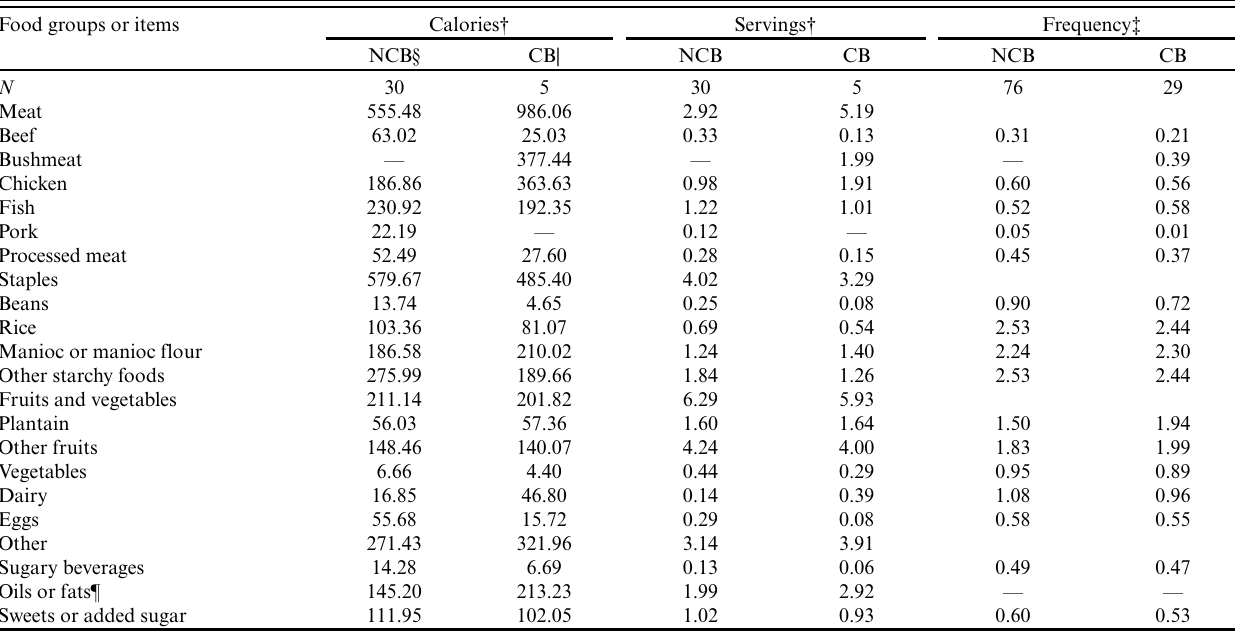
Table 4. Household consumption of main food groups and items per adult equivalent per day (calories and servings) according to declaration of bushmeat